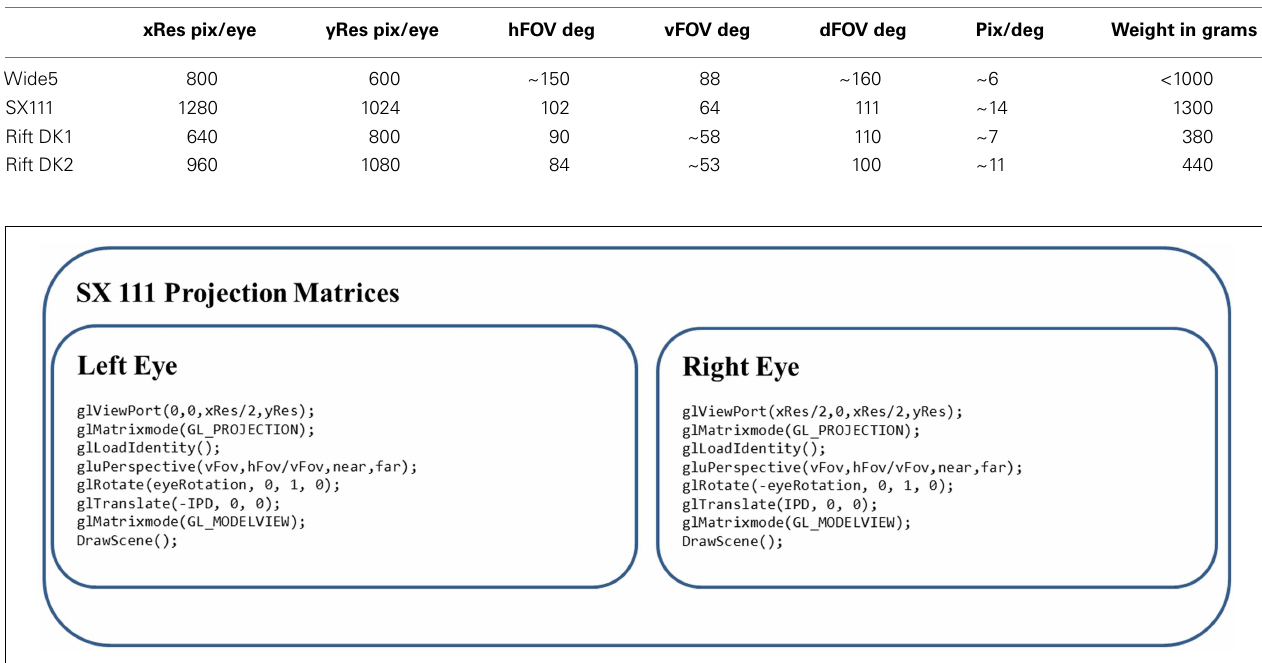
Table 3 | Comparison of HMD properties .